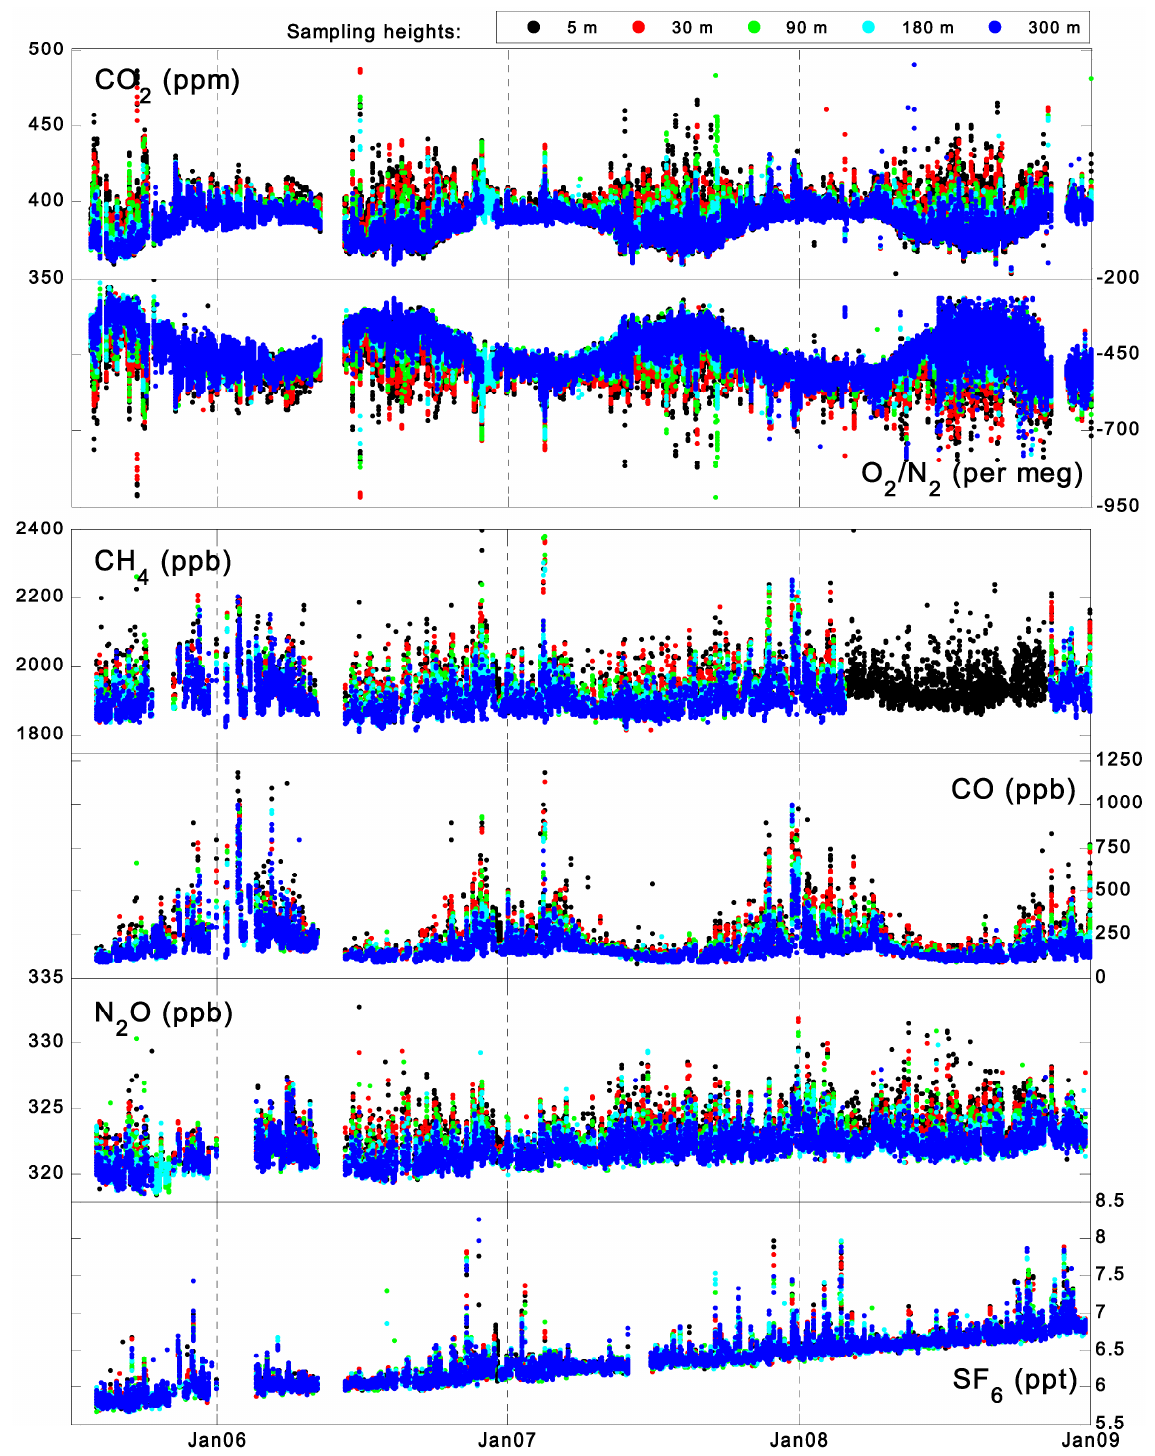
Fig. 5. Time series of CO 2 , O 2 /N 2 , CH 4 , CO, N 2 O and SF 6 , from different sampling heights. CH 4 data between March and November 2008, except for the 5m height, were excluded following quality check. O 2 /N 2 data between June and November 2008 show large noise due to an instrumental problem; they were not eliminated during the quality check, but their potential use is limited by the large